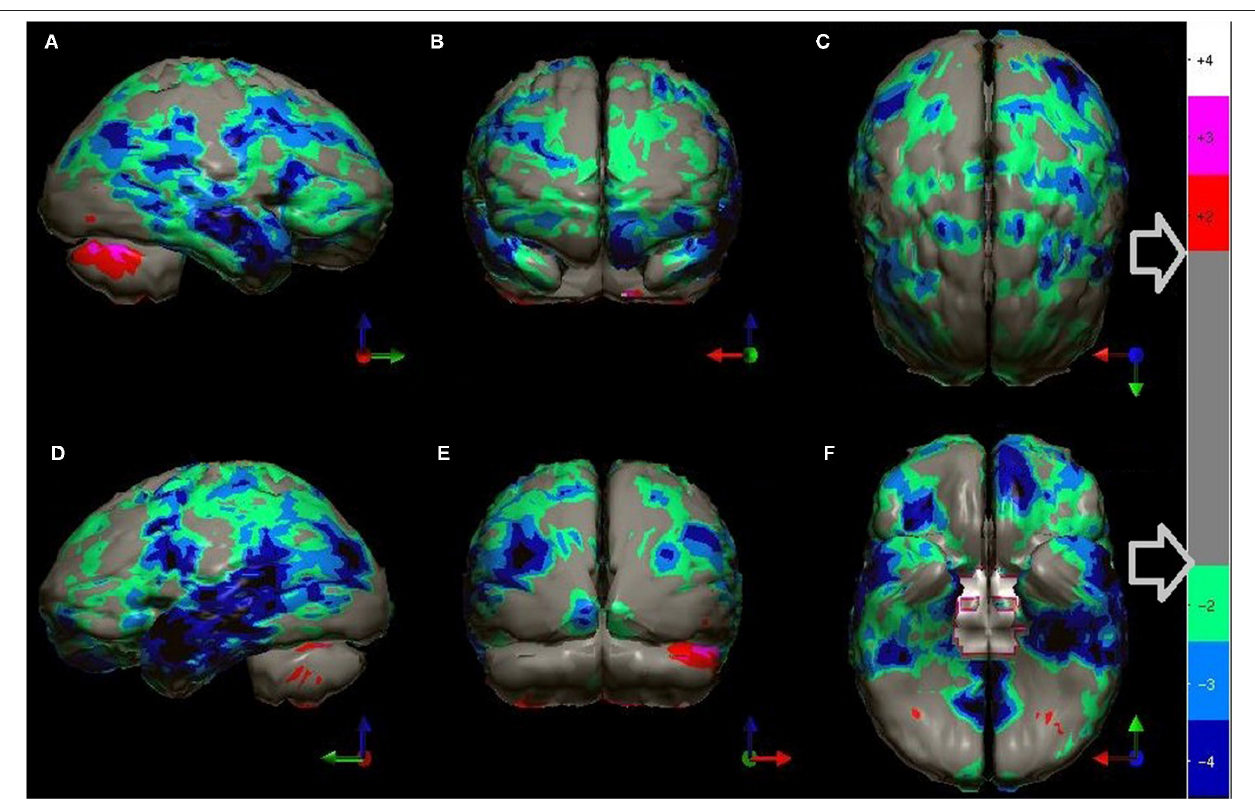
FIGURE 12 | The patient’s data is compared to a normative database ( N = 68). A map of statistically significant differences can be generated using the Oasis software by Segami, Inc. The color scale is the same as in Figure 10 . Diffuse decreased perfusion in all cortical areas can be appreciated. More extensive involvement of the bilateral temporal lobes is more clearly demonstrated with this map of statistical differences. Map is displayed in the following views: (A) right lateral, (B) frontal, (C) superior, (D) left lateral, (E) posterior, and (F) inferior with cerebellum